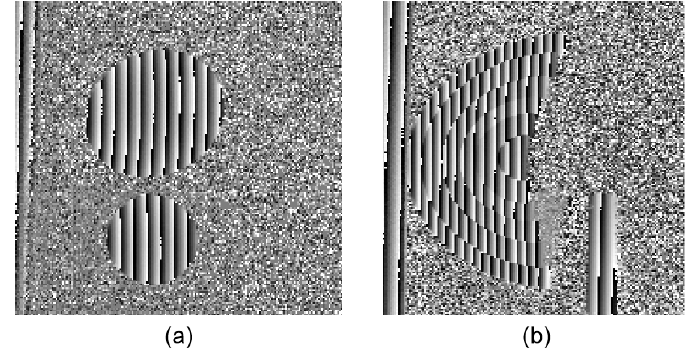
Figure 11. Wrapped phase maps of the measured specular objects. ( a ) Two separate specular objects; ( b ) Discontinuous fan-shaped mirror step.